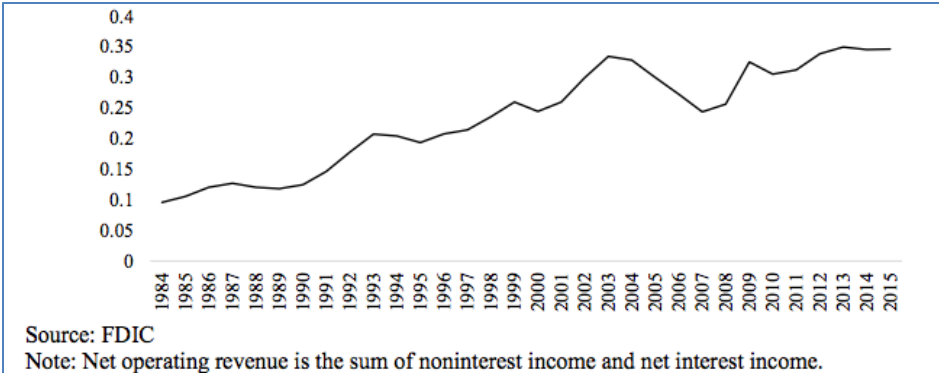
Figure 2: Non-interest income as a share of net operating